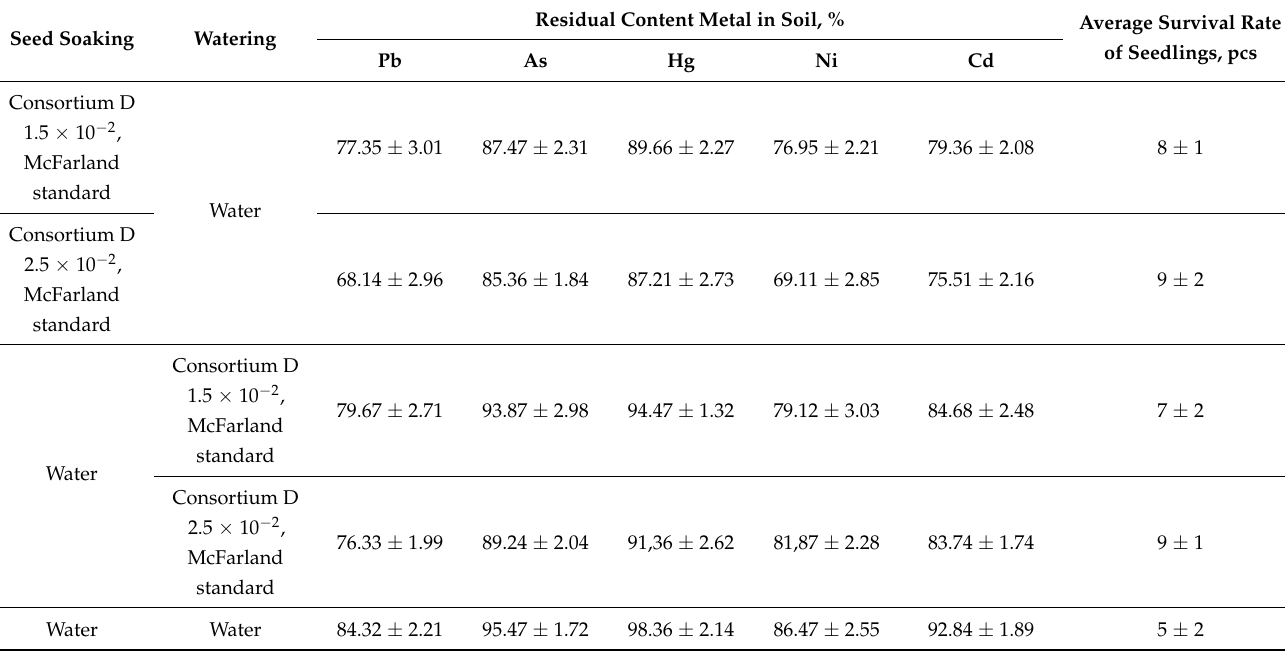
Table 10. Efficiency of soil phytoremediation when treated with Consortium